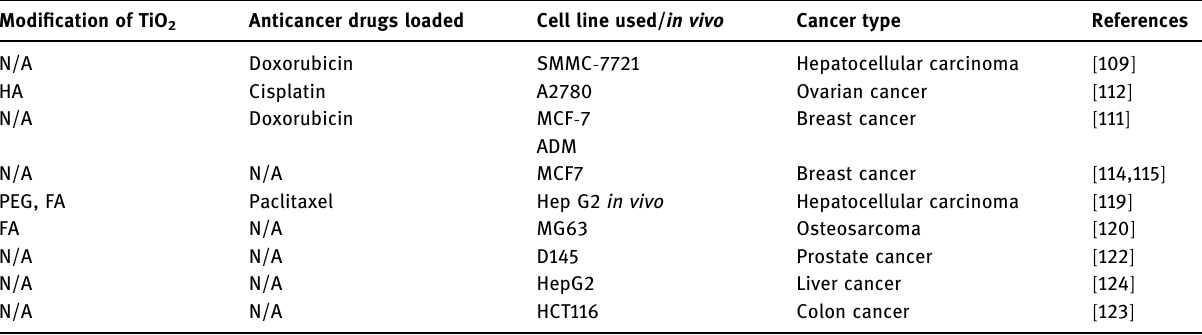
Table 3: Studies showing anticancer activity of TiO 2 - NPs alone, modi fi ed TiO 2 NPs, and drug - loaded TiO 2 - NPs against di ff erent cancer types Modi fi cation of TiO